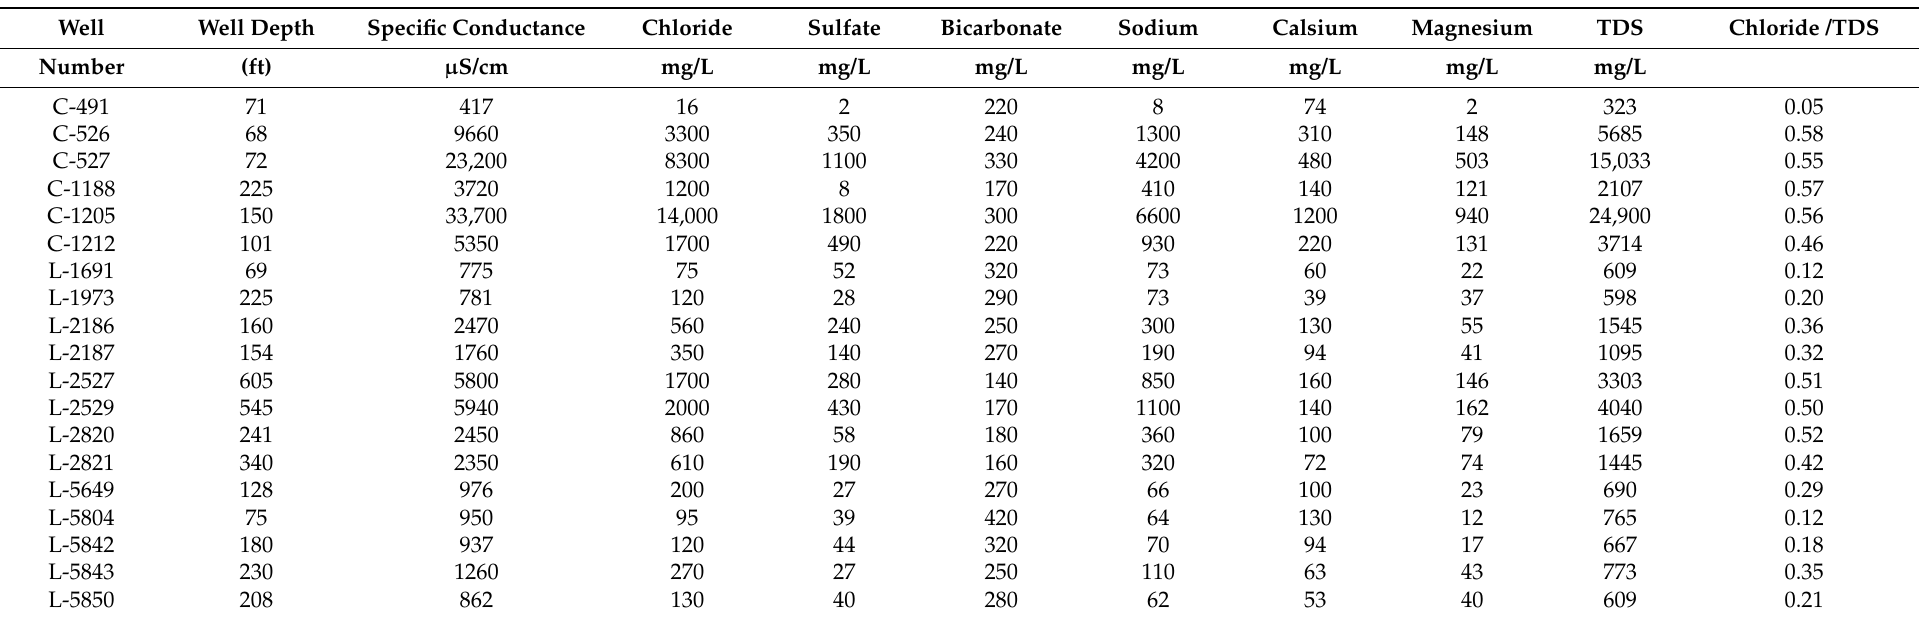
Table 3. Measured chloride and TDS concentrations